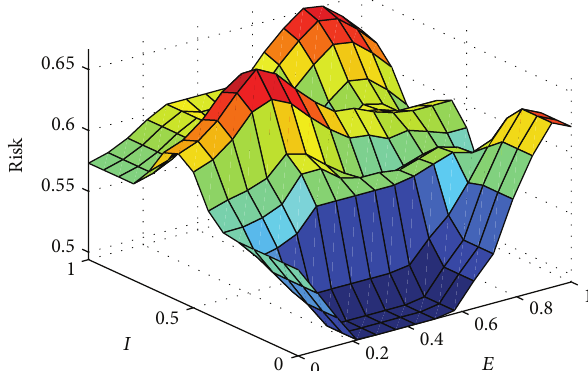
Table 3: The Pareto solution combination.